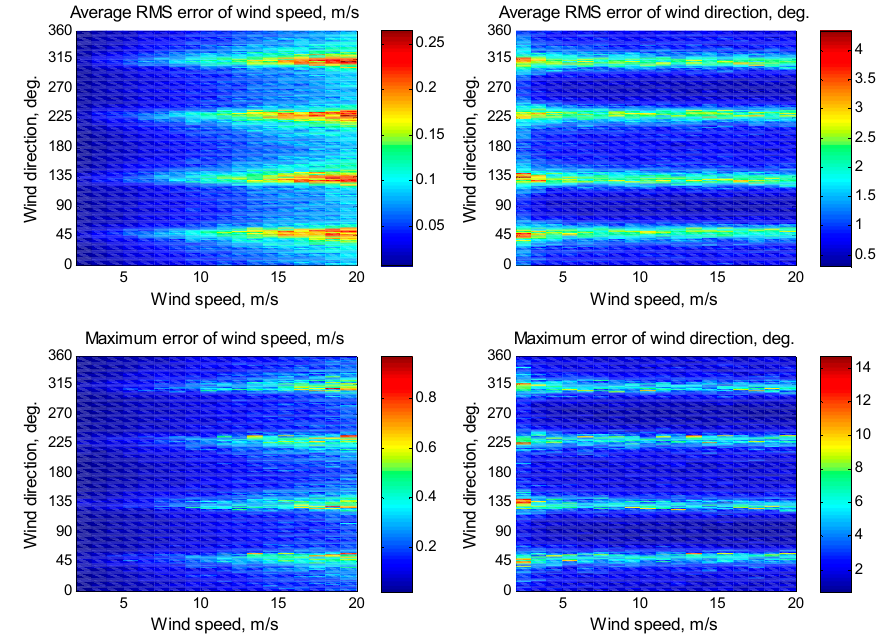
Figure 6. Simulation results for the mounting angle of a beam axis in the horizontal plane of 30° with the assumption of 0.1 dB instrumental noise at wind speeds of 2–20 m/s for the incidence angle of 30° with 5000 averaged NRCS samples for each azimuthal angle.